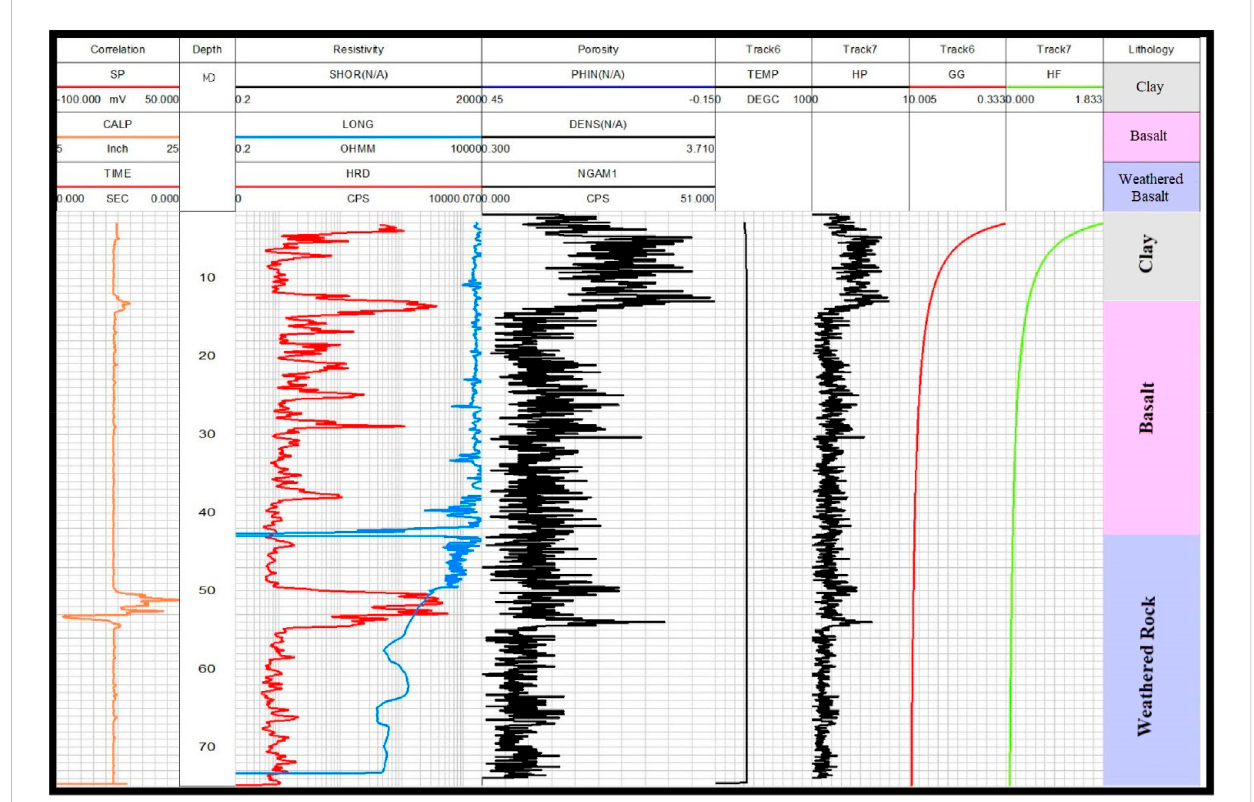
FIGURE 2 Detailed view of well log pro fi le of RAH-10 well. Track 1 (correlation) shows the caliper log. Track 2 (resistivity) demonstrates the variation of the resistivity log. Track 3 showed the natural gamma ray log and density log the value of the density log is merged with the natural gamma ray log.